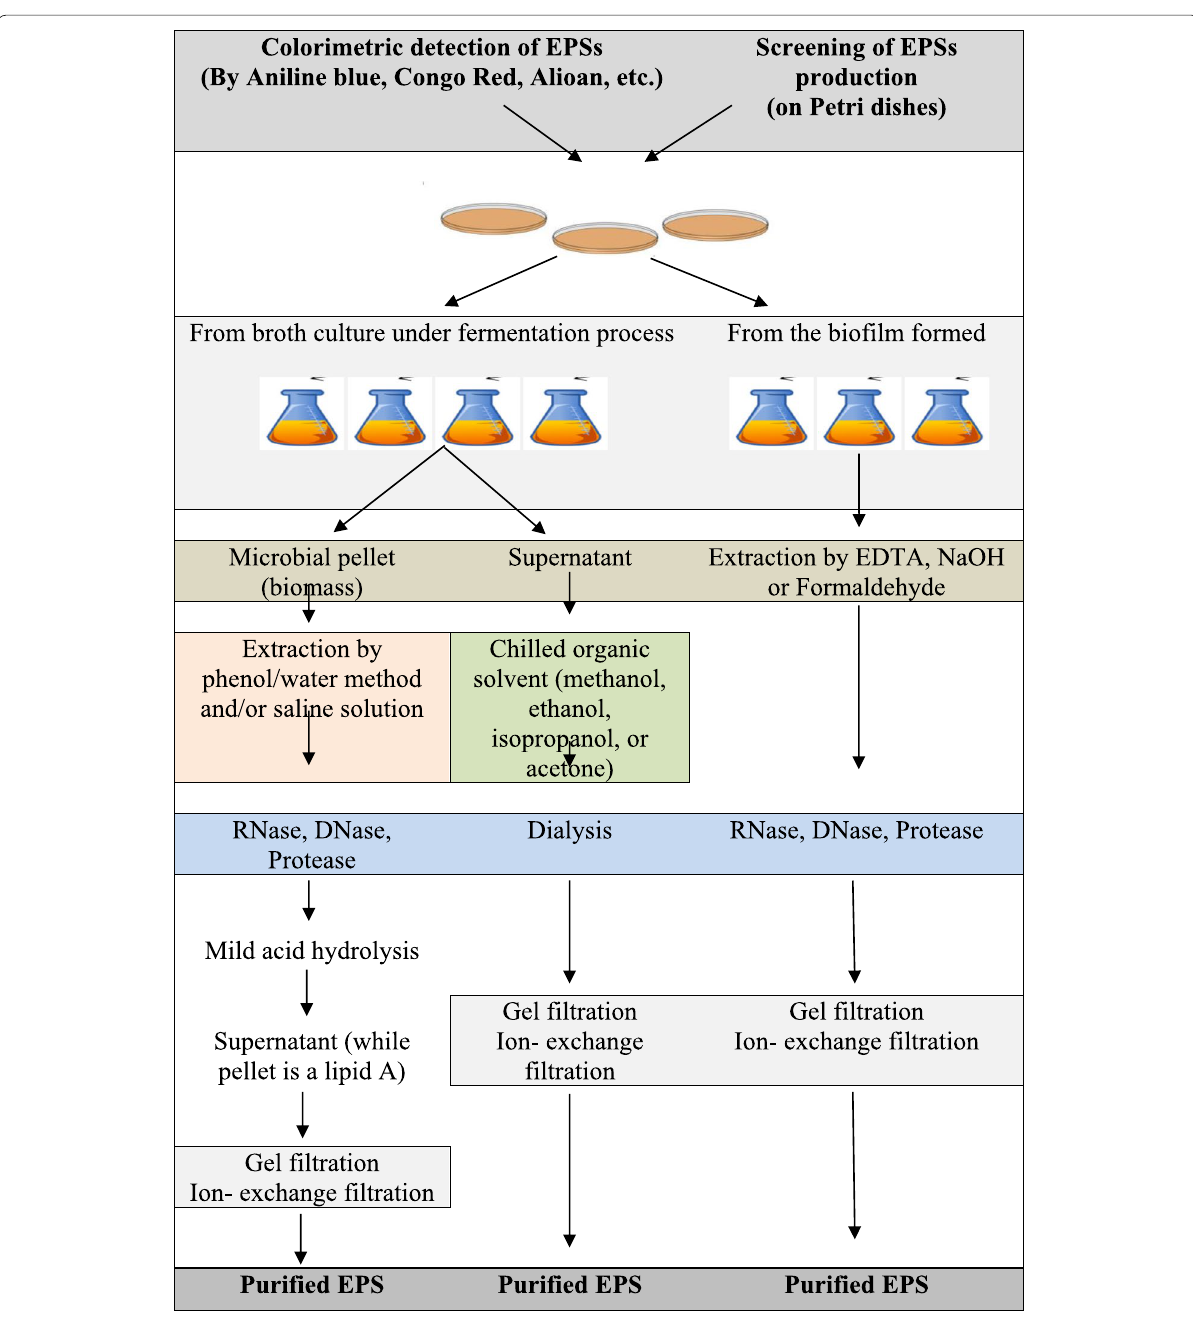
Fig. 5 The general steps for production, extraction, and characterization of